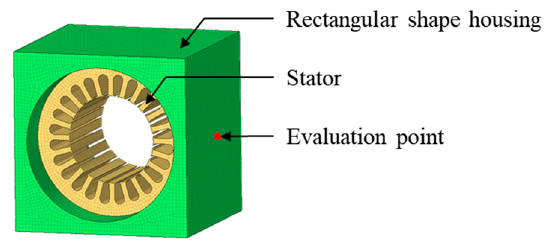
Figure 6. Rectangular shape housing initial design.